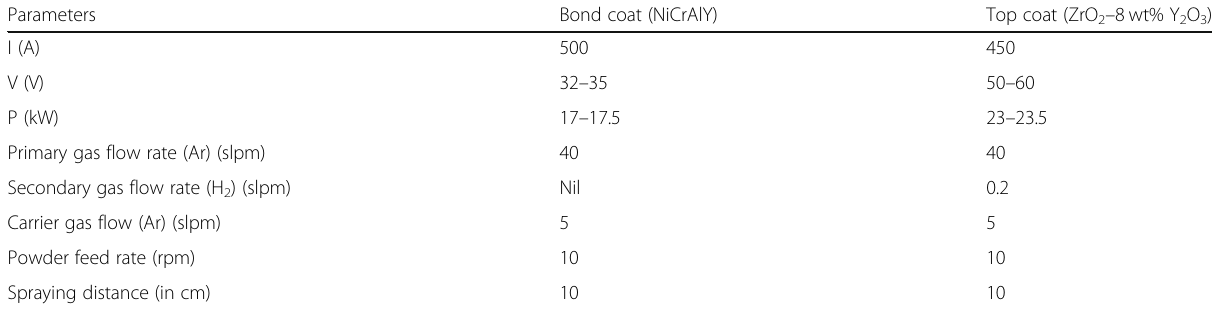
Table 2 Plasma spray parameters Parameters